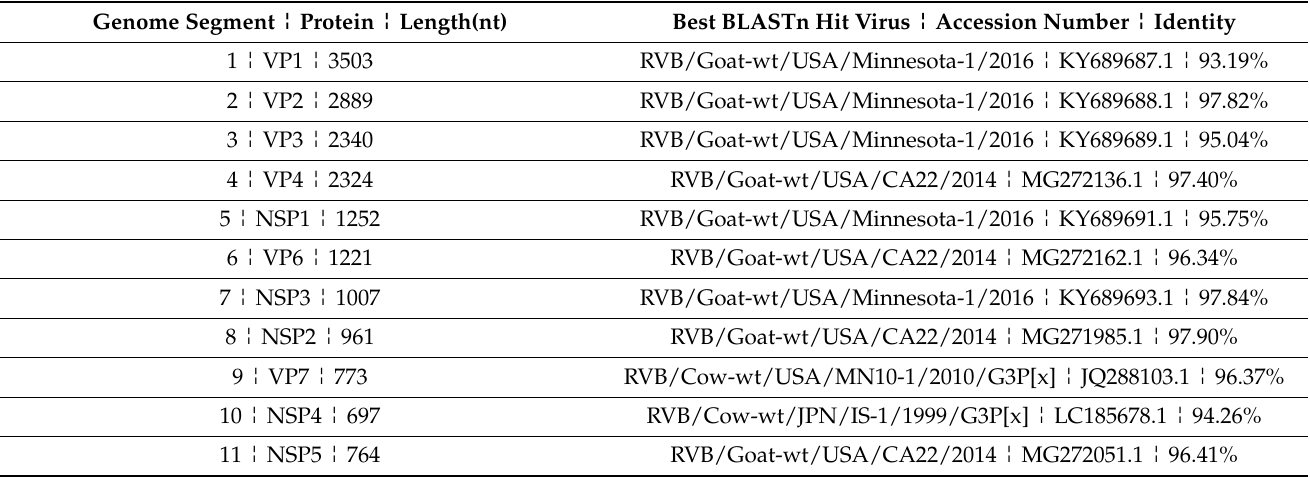
Table 1. BLASTn analysis of the eleven genome segments of RVB/Horse-wt/USA/KY1518/2021. Genome Segment ¦ Protein ¦